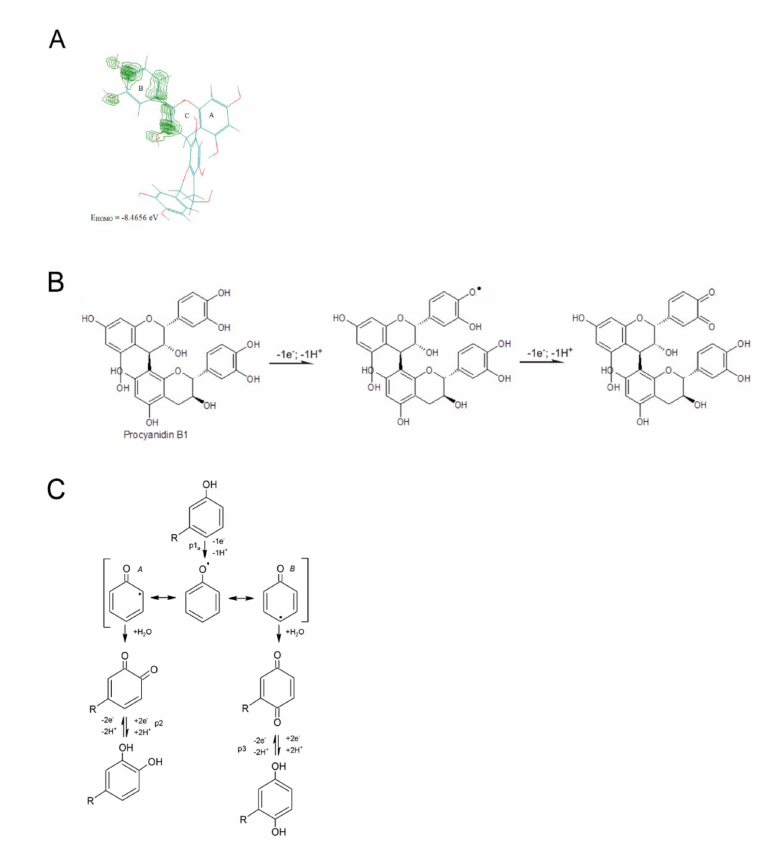
Figure 3. ( A ) Electron density and probable sites in procyanidin B1 molecule susceptible to electro-oxidation; ( B ) proposed electro-oxidation of procyanidin B1; ( C ) mechanism of phenol